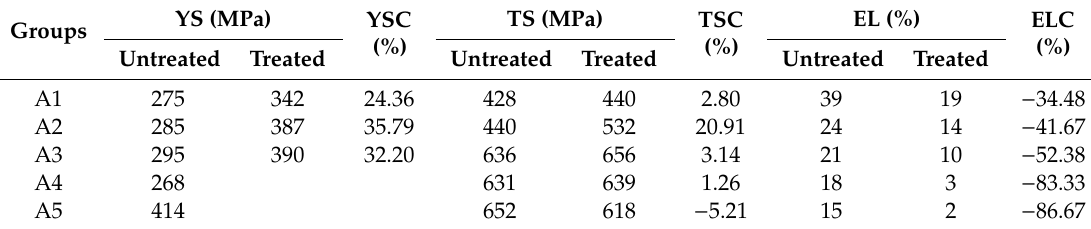
Table 4. Tensile test results of the bionic treatment samples and untreated